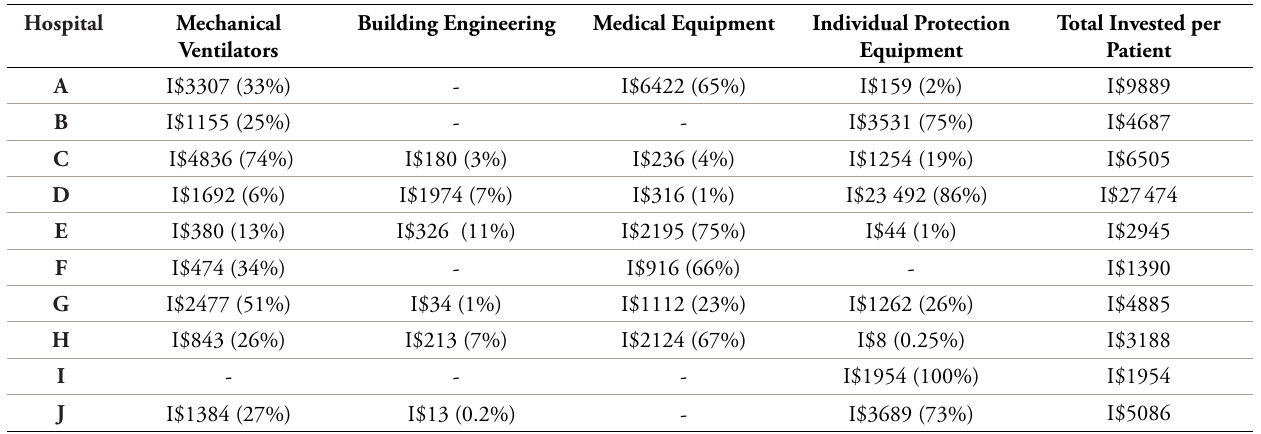
Table 3: Investment for COVID-19 Management Preparedness per Patient Assisted Hospital